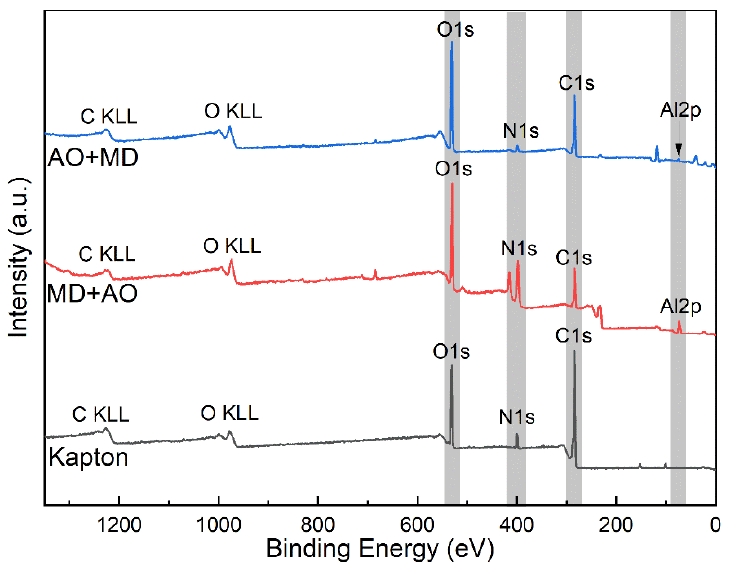
Figure 10. XPS full scan energy spectrum of original Kapton film and film after MD + AO and AO + MD load spectrum test.